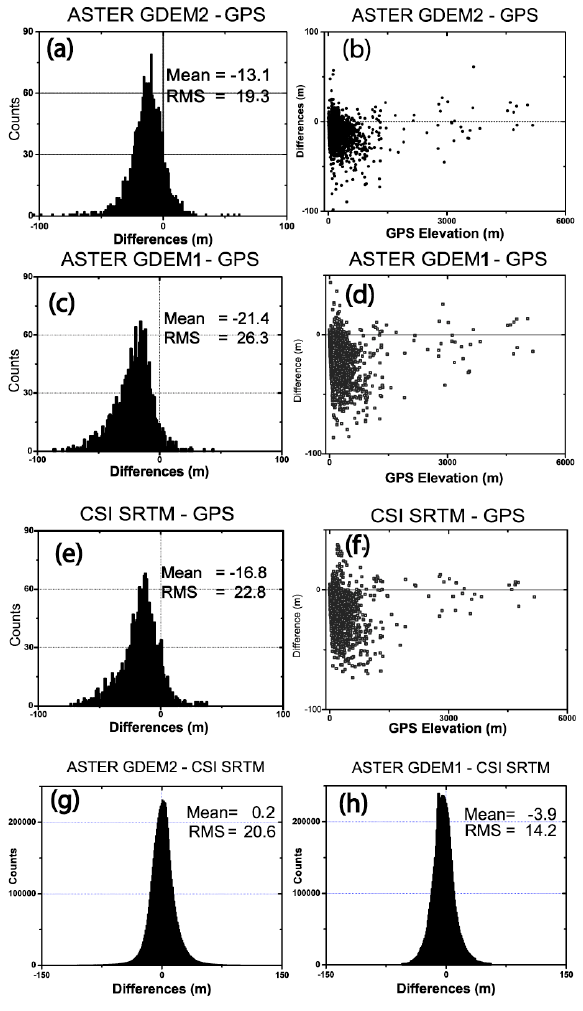
Figure 3. Histograms of the elevation differences among GDEM1, GDEM2 and CSI SRTM against overall GPS points ( a , c , e ) and raster-based comparisons between GDEM and SRTM over all of the five study areas ( g , h ). Elevation differences distribution of GDEM-GPS and SRTM-GPS over all of the five study areas ( b , d , f ). Corresponding GPS elevation is shown in the horizontal axis. Absolute Vertical Accuracy : The results of the elevation differences between ASTER GDEM and GPS points in each of the five test areas are shown in the right column of Figure 2. The statistics of absolute vertical accuracies of GDEM2, as well as that of GDEM1 and SRTM v4.1 are listed in Table 1. Note that the strategy of gross error elimination was employed in the previous accuracy validation of GDEM1 and SRTM-v4.1 (Li et al . 2012) and improved the RMS values by 1.1m and 2.4m respectively, while not for GDEM2 in order to statistically derive its original error characteristics. Compared to the GDEM1-GPS after gross error removal, RMS values of GDEM2-GPS in the four study areas reduce 1~9m, except for a Table 1. Statistics of absolute vertical accuracies for ASTER 1.9m rise in Tibet. Therefore, there is a great improvement GDEM v1, v2 and CSI SRTM by comparison with GPS benchmarks. The study region names are abbreviated in the first column, which stand for Three Gorges, Xi’an, Nanning, Guangdong and Tibetan Plateau respectively. The correlation, minimum, maximum, mean and RMS values of DEMs-GPS errors are computed. Unit is metres.